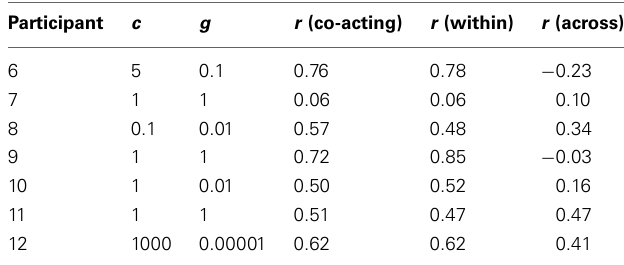
Table 2 | The best c , g parameters found after optimization for each participant for fMRI classification, and the time trace correlations ( r ) averaged across that participant’s four